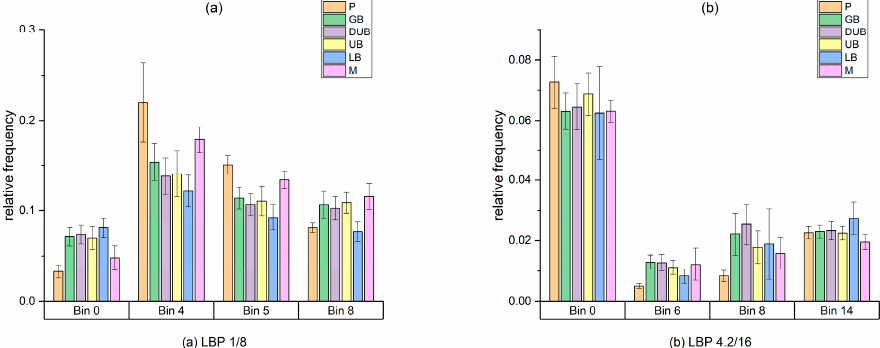
Figure 11. Individual bins of the LBP 1 / 8 ( a ) and LBP4.2 / 16 ( b ) histograms for all six microstructure classes, for a better illustration of differences. Error bars are standard deviations to indicate the scattering of all analyzed images.